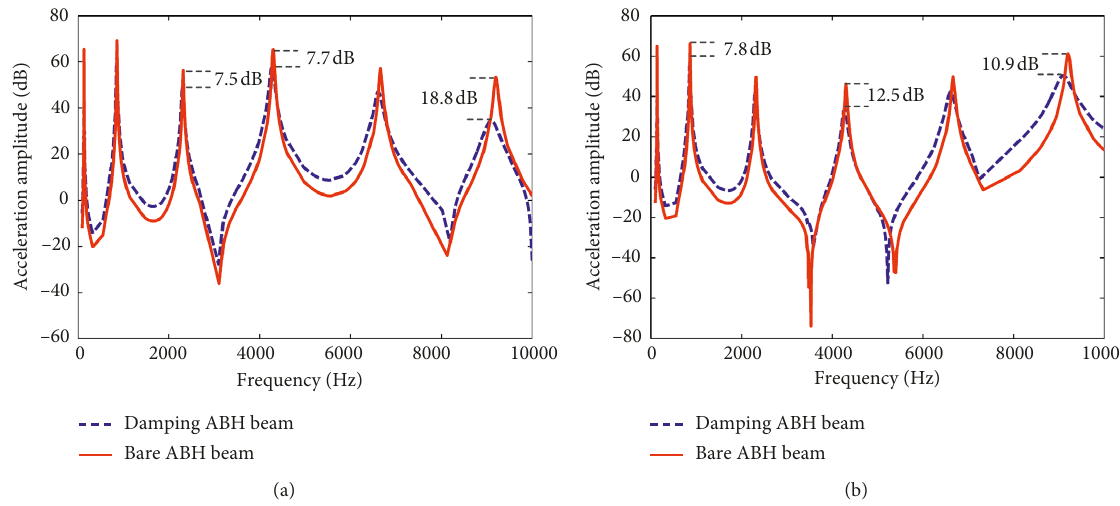
Figure 7: Effects of the damping layers on the acceleration responses: (a) ABH region ( x ( x m � 10 . 87 cm).